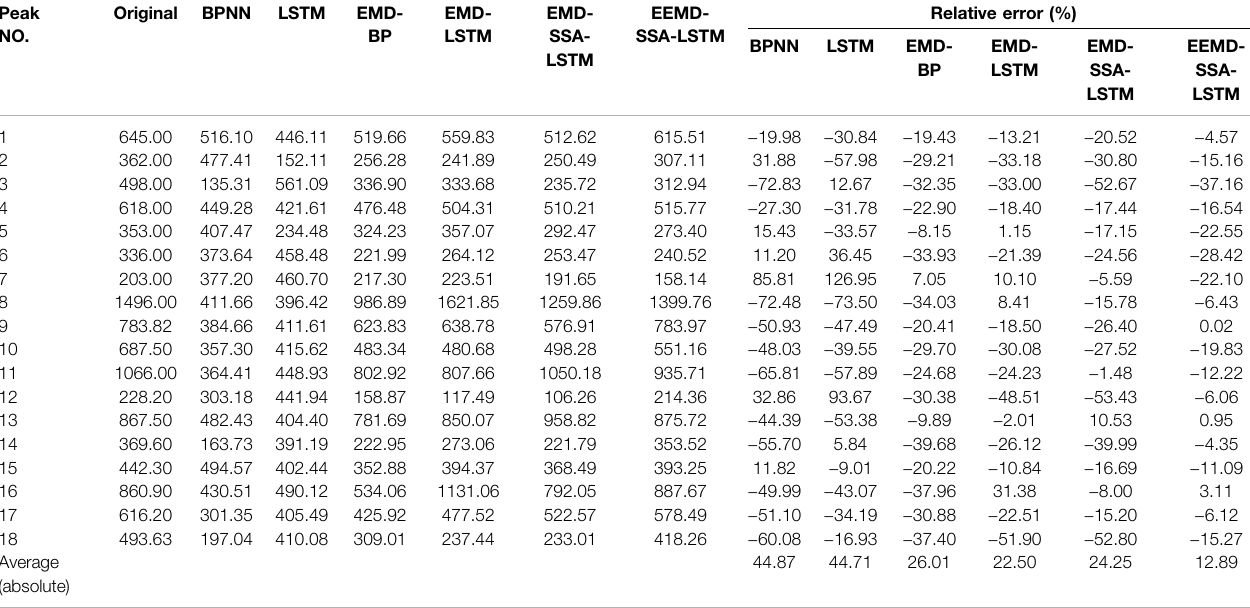
TABLE 6 | Peak fl ow estimates of different models for the Xinfengjiang Reservoir during the validation period. Peak